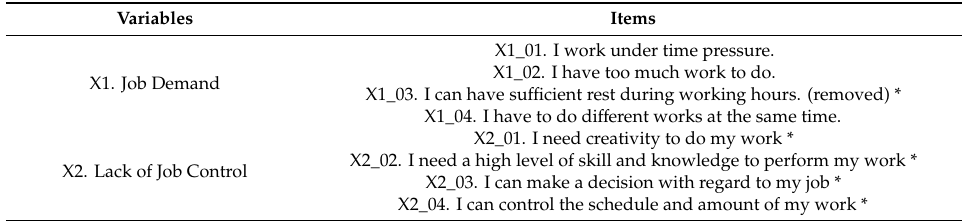
Table 1. Questionnaire items on work environment factors.